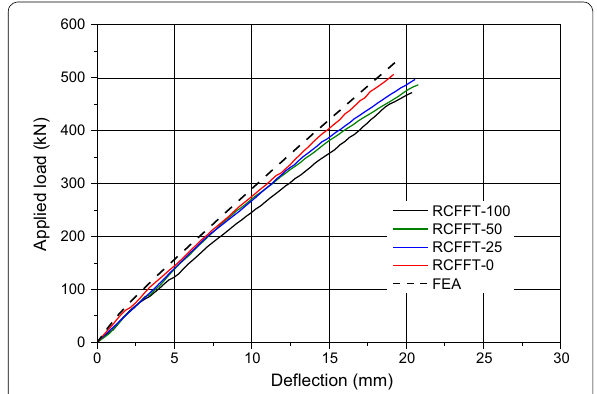
Fig. 7 Load–deflection response of RCFFTs at quarter span.